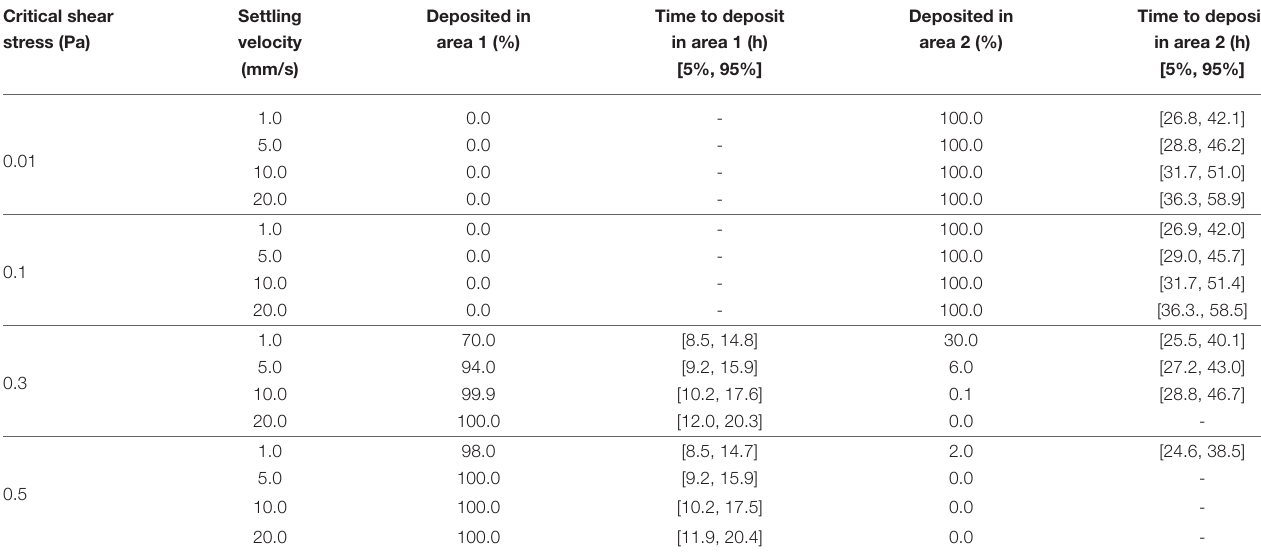
TABLE 2 | Distribution of deposited OPAs and time to deposition.